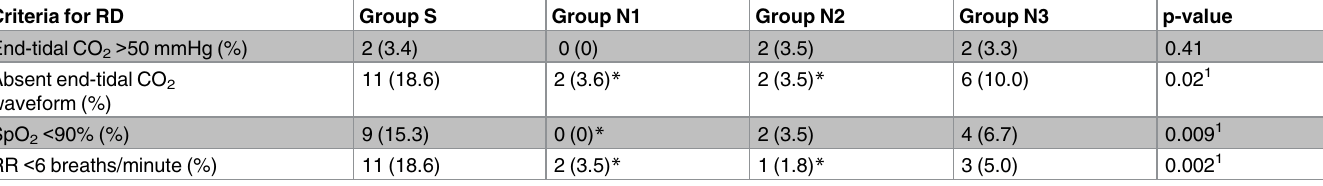
Table 5. Patients meeting the criteria for respiratory